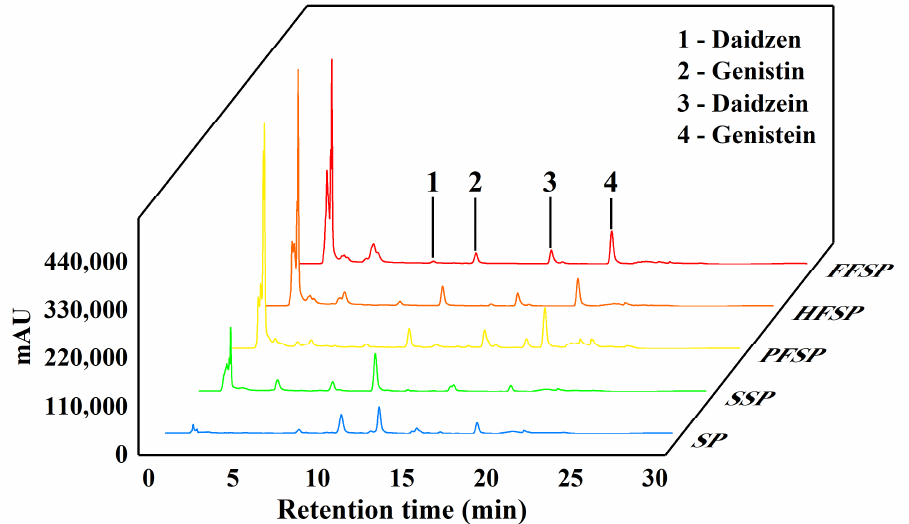
Figure 2. Liquid chromatogram of soybean isoflavones in different soybean meal powders. SP: soy- bean meal powder; SSP: sterilized soybean meal powder; PFSP: Pleurotus ostreatus fermented soy- bean meal powder; HFSP: Hericium erinaceus fermented soybean meal powder; FFSP: Flammulina velutipes fermented soybean meal powder.